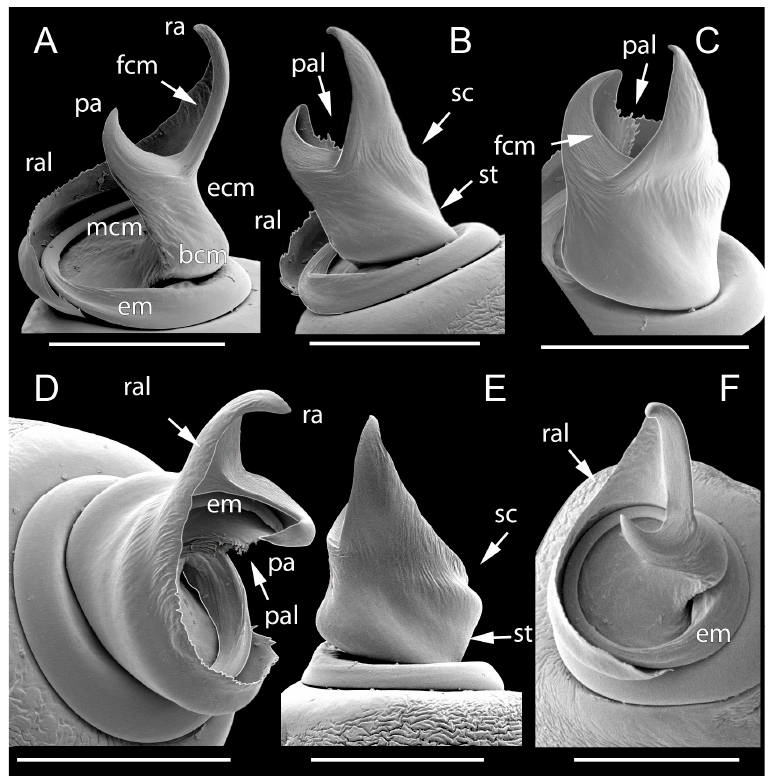
Figure 3. SEM images of the conductor and embolus of Loureedia maroccana , male paratype. ( A ) oblique ventral view; ( B ) oblique retrolateral view; ( C ) apico-retrolateral view; ( D ) apico-prolateral view; ( E ) retrolateral view; ( F ) apico-ventral view. Abbreviations: bcm: basal conductor